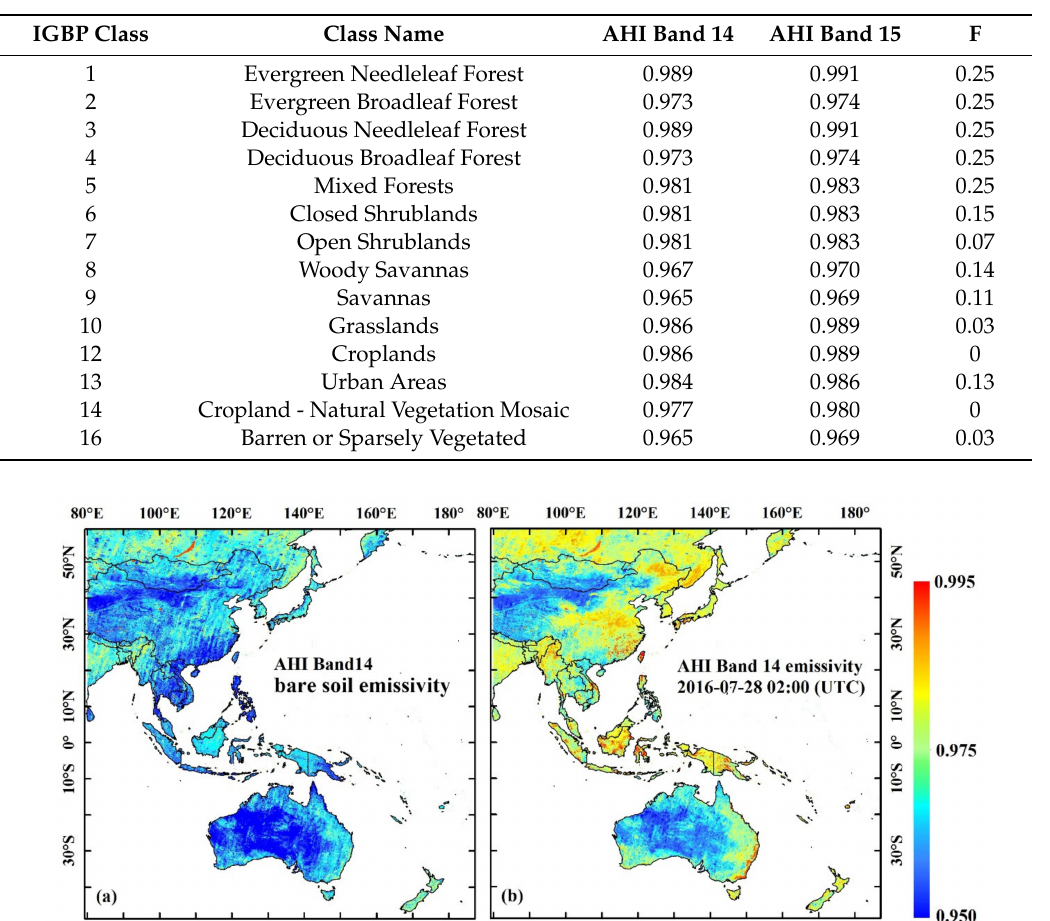
Table 2. Vegetation emissivities and cavity terms of di ff erent land cover types in AHI bands 14 and 15 [35].